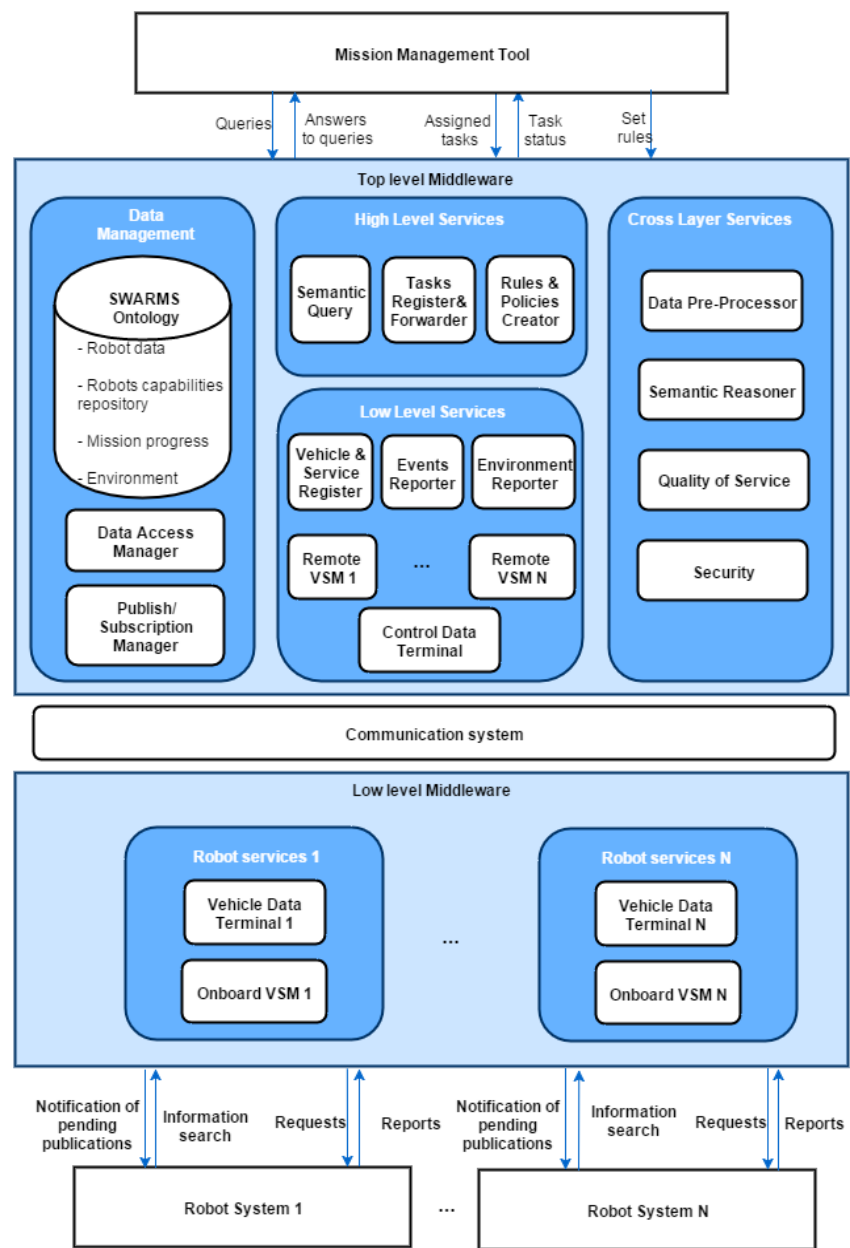
Figure 1. The SWARMs semantic middleware architecture.